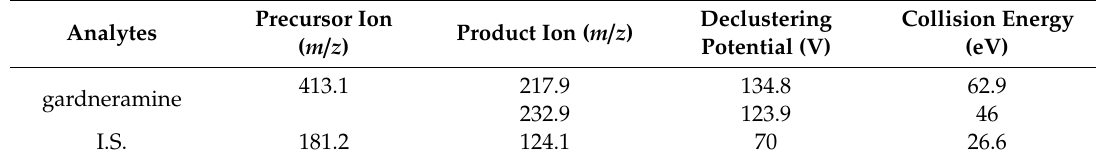
Table 1. Optimized mass spectrometry conditions for the determination of gardneramine and